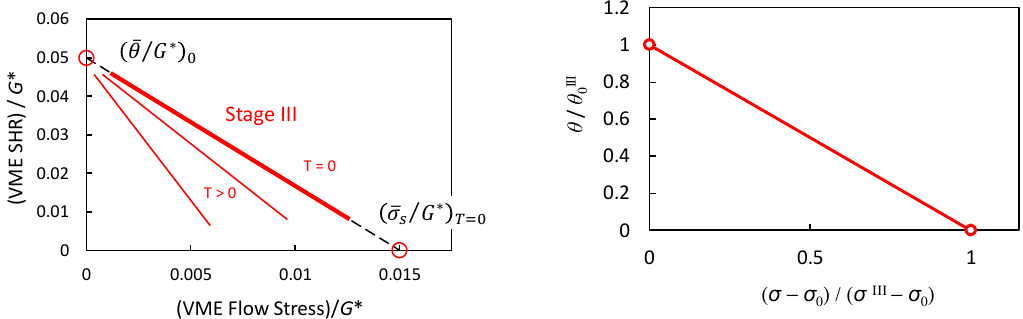
Figure 2. Sketch of Stage III of plastic deformation according to the model of Kocks and Mecking [3].